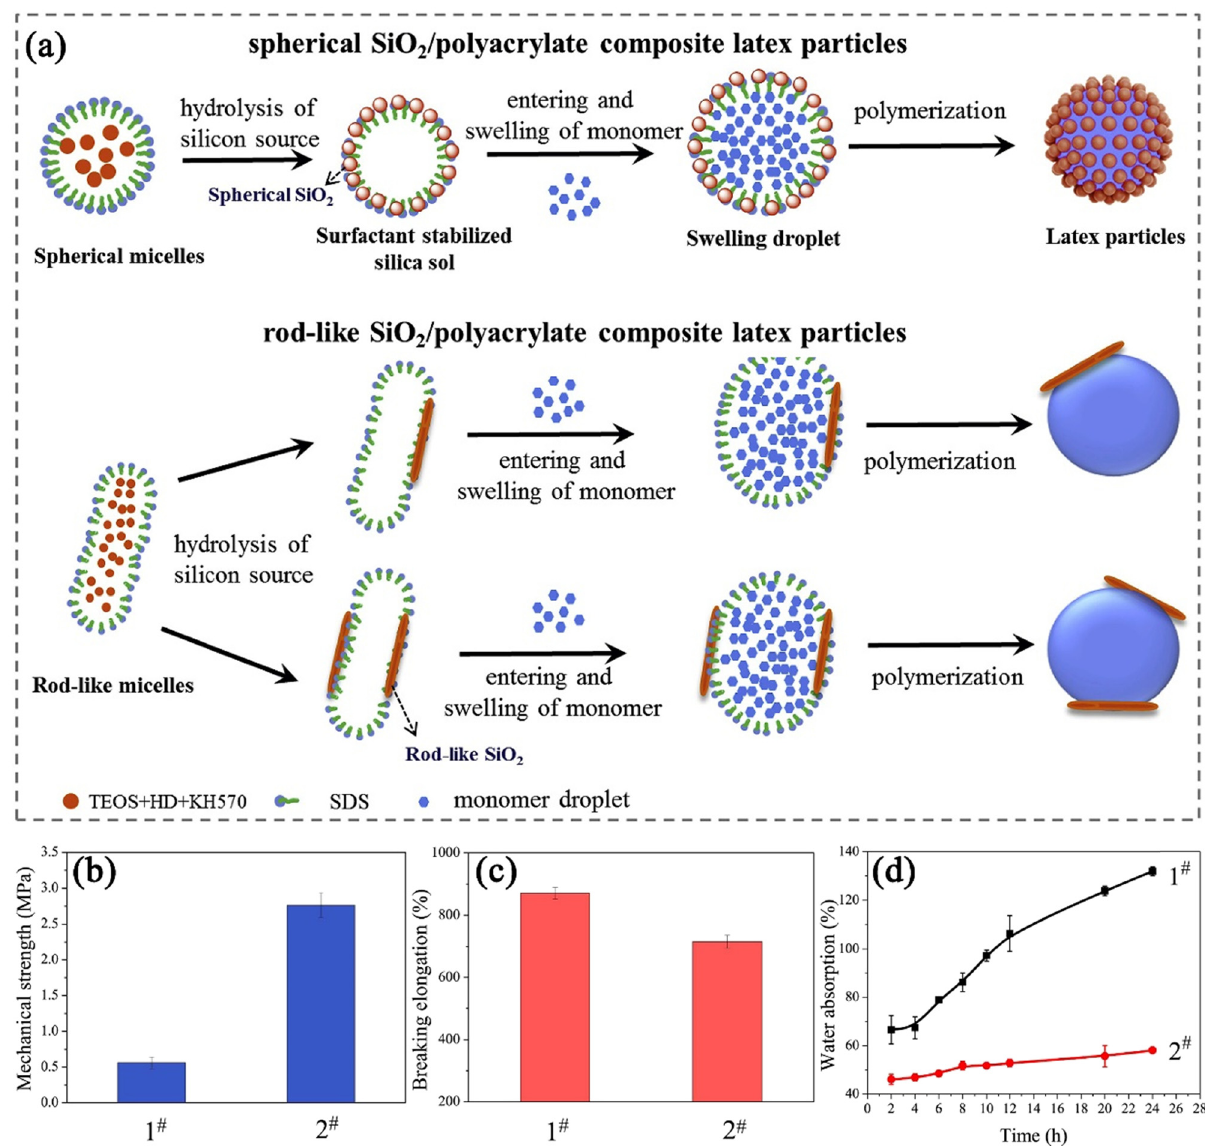
Figure 6: ( a ) Schematic illustration of the preparation of spherical and rod - like SiO 2 /PAA hybrid nanocomposite latexes, ( b ) mechanical strength, ( c ) elongation at break, and ( d ) water absorption. Note: 1 # and 2 # are spherical and rod - shaped SiO 2 /PAA composite fi lms, respectively [ 66 ] ; copyright 2019 with permission from Elsevier Science